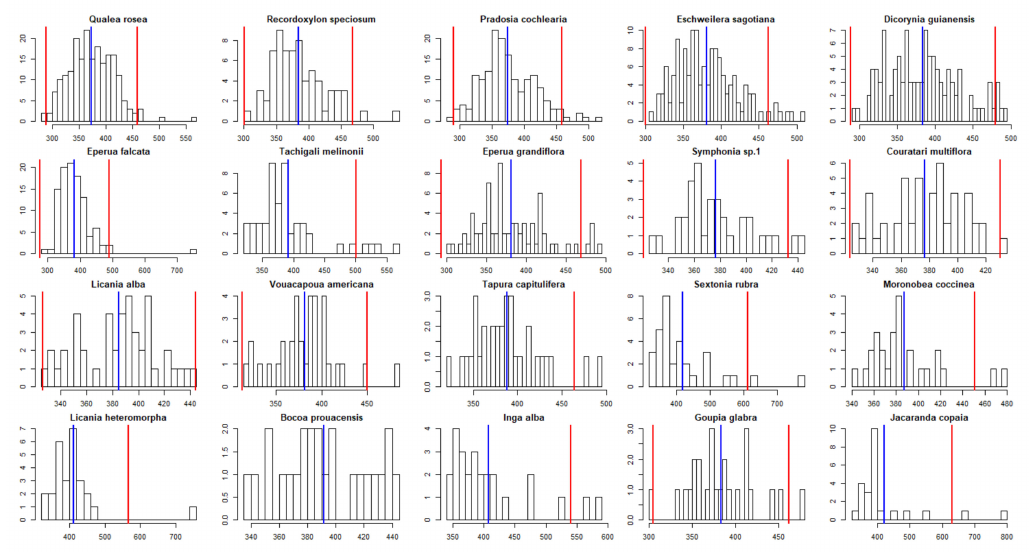
Figure 6. Within-species Mahalanobis distance (computed per crown). The blue line represents the mean of the Mahalanobis distance. The red lines represent the mean plus or minus two standard deviations.